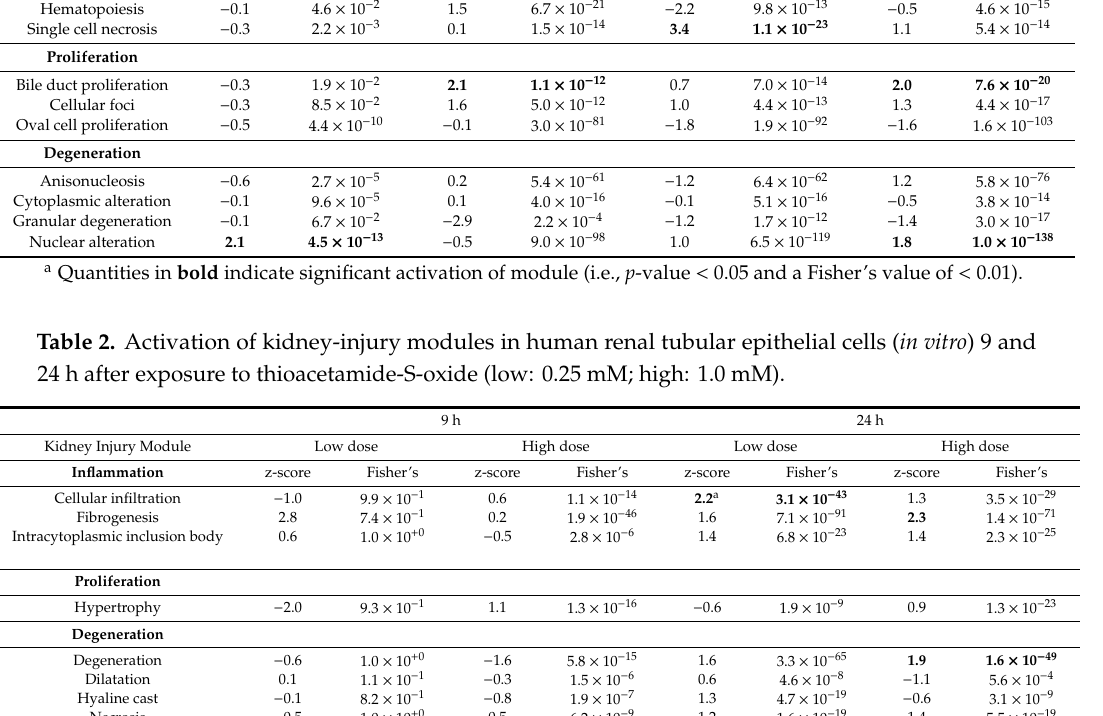
Table 1. Activation of liver-injury modules in human primary hepatocytes (in vitro) 9 and 24 h after exposure to thioacetamide-S-oxide (low: 0.125 mM; high: 0.25 mM). 9 h 24 h Liver Injury Module Low dose High dose Low dose High dose z-score Fisher’s